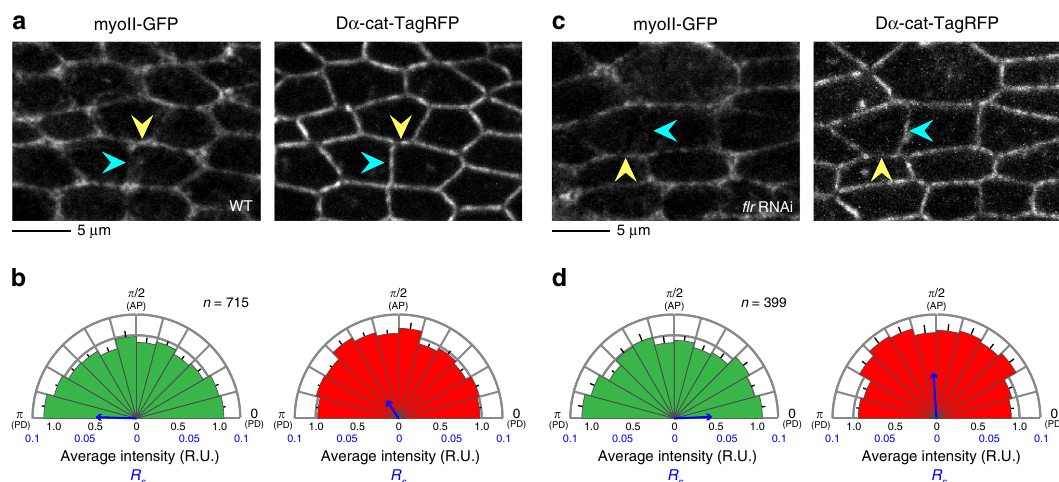
Fig. 5 The global myo-II polarization pattern is not affected by fl r RNAi. a , c myo-II-GFP (left) and the AJ marker D α -cat-TagRFP (right) in WT ( a ) and fl r RNAi ( c ) wings at 24 h APF. Yellow and blue arrowheads indicate PD and AP junctions, respectively. b , d Directional bias of myo-II-GFP signal intensity (left) and D α -cat-TagRFP signal intensity (right) along junctions in WT ( b ) and fl r RNAi (d ) wings was quanti fi ed as have been done in Fig. 1b. The number of junctions examined ( b , d ) is indicated. Data are presented as the mean ± s.e.m. ( b , d ). Scale bars: 5 µ m ( a , c